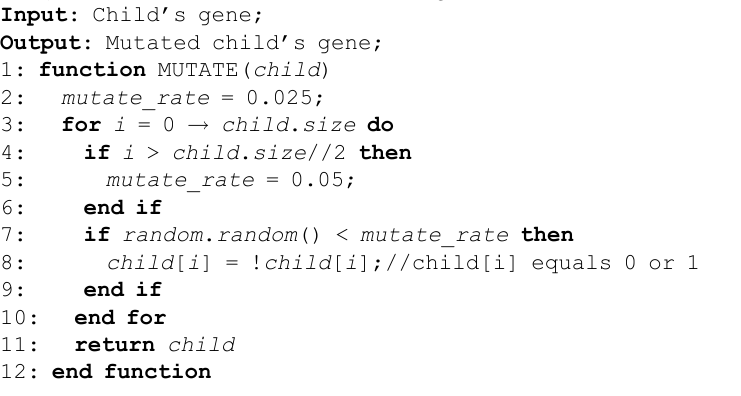
Algorithm 2 Mutate child with alter each gene if rand number less than mutate rate.